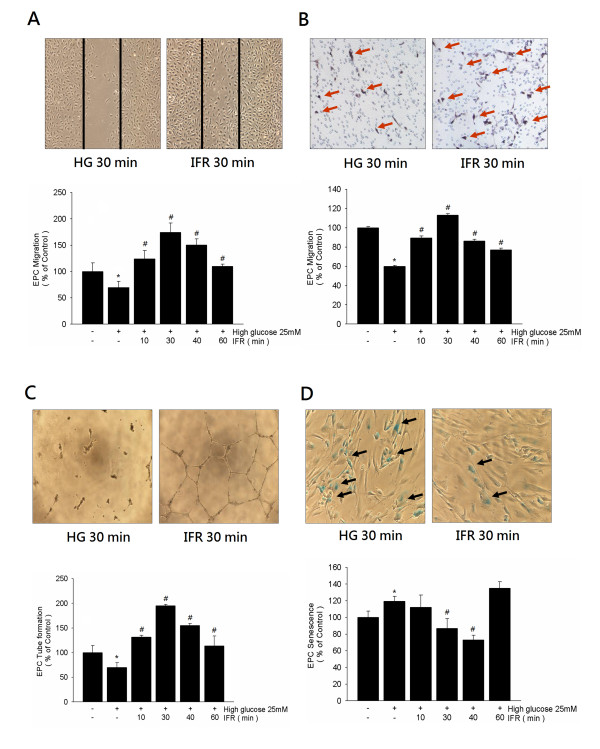
 Effects of IFR therapy on EPC migration, tube formation, and senescence in vitro. (A,B) Scratch test and modified Boyden chamber assay were used to assess the migratory function of ECFCs in high glucose conditions. Boyden chamber assay using VEGF as a chemoattracting factor was used to evaluate the effects of IFR radiation on EPC migration. (C) An in vitro angiogenesis assay for late ECFCs used ECMatrix gel. Representative photos for in vitro angiogenesis are shown. Cells were stained with crystal violet, and the averages of the total area of complete tubes formed by cells were compared by using computer software. (D) To determine the onset of cellular aging, acidic ß-galactosidase was used as a biochemical marker for acidification, typical for ECFCs senescence. Data are means ± SEM; n = 4 in each experiment.